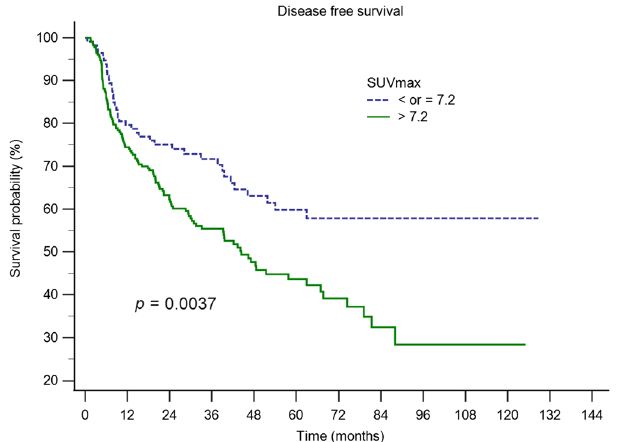
Figure 3. Kaplan–Meier curves for DFS of patients disaggregated into two groups using the tSUVmax cutoff value of 7.2. Results show significant difference in DFS between the two groups (p =